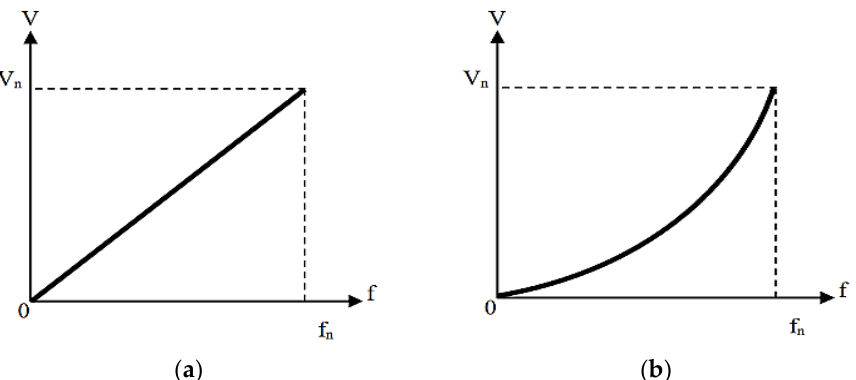
Figure 4. The relation between the stator voltage and frequency in ( a ) Linear V/f control; ( b ) Quadratic V/f control.